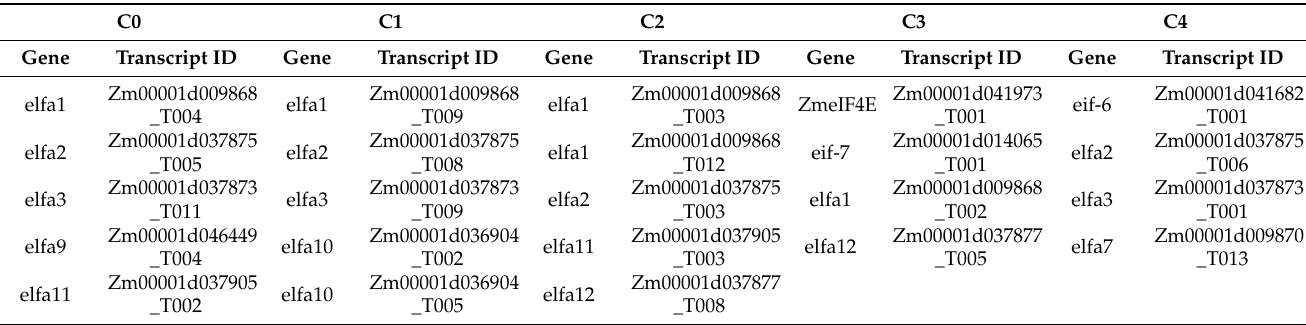
Table 4. Transcripts coding for translation/elongation factors found in clustering of transcript expression patterns (CTEPs) C0 to C4 (see Figure